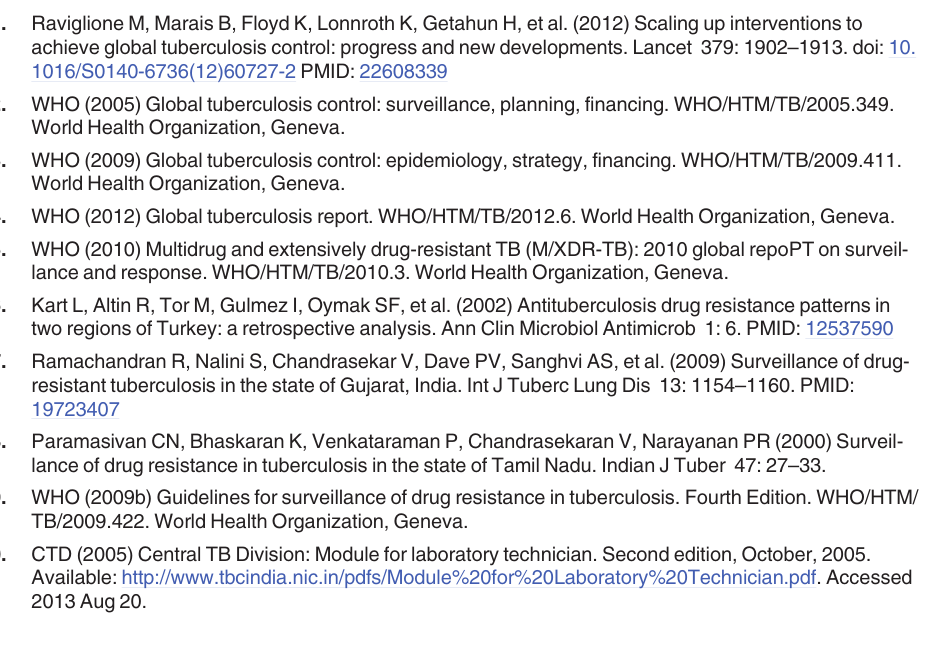
S1 Table. 1A — The age and sex wise distribution of DST has not done Vs DST available among new and previously treated cases of tuberculosis. 1B — The DMC wise comparison of DST has not done Vs DST available among new and previously treated cases of tuberculosis. S2 Table. Age and sex wise comparison of MDR-TB cases among HIV positive and negative